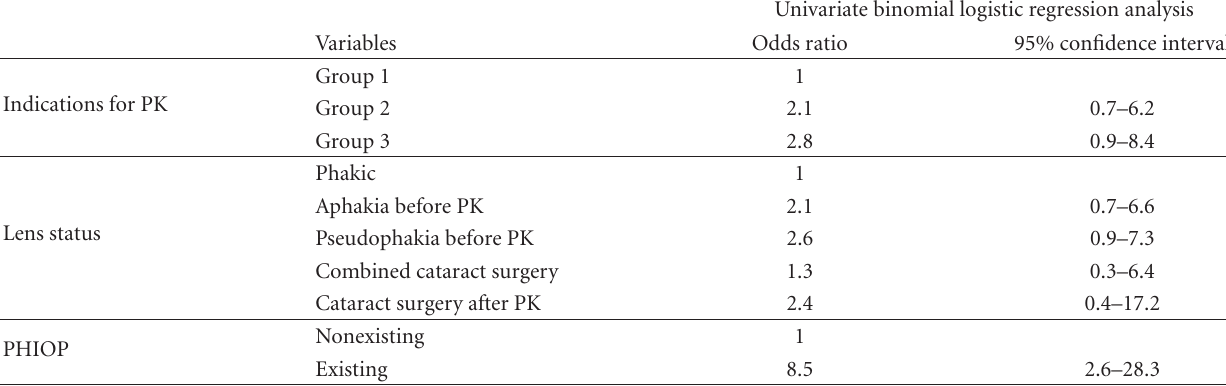
Table 4: Odds ratio and 95% confidence interval from binomial regression of the likelihood of developing post-keratoplasty glaucoma (PKG) (versus without PKG) on indications for penetrating keratoplasty (PK), the lens status, and previous high intraocular pressure